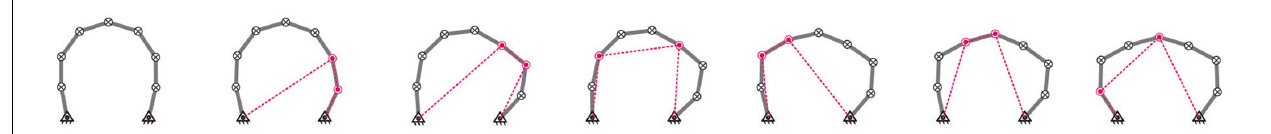
FIGURE 4 | Reconfiguration steps of the 9-bar linkage.